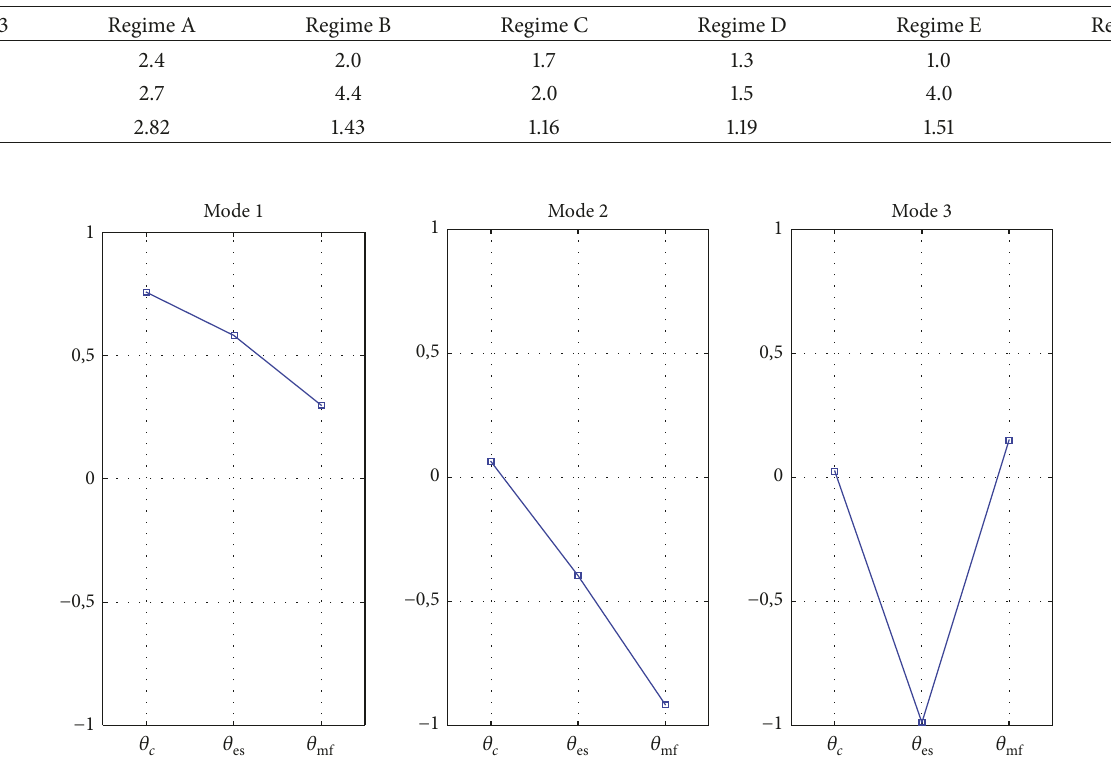
Figure 12: Normalized mode shapes of the